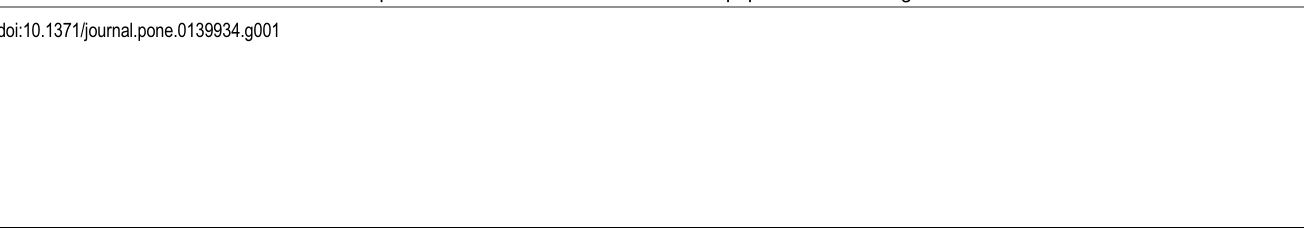
PLOS ONE | DOI:10.1371/journal.pone.0139934 November 6,